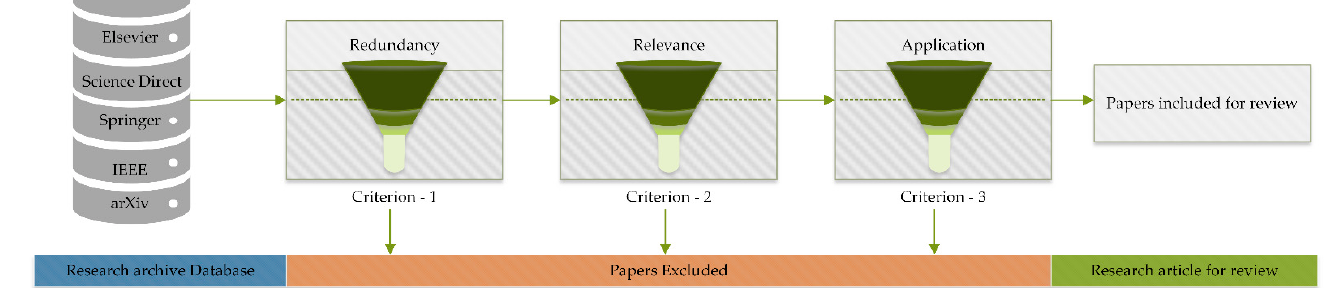
Figure 5. The representative flow of data curation, with criterion filters and final list.